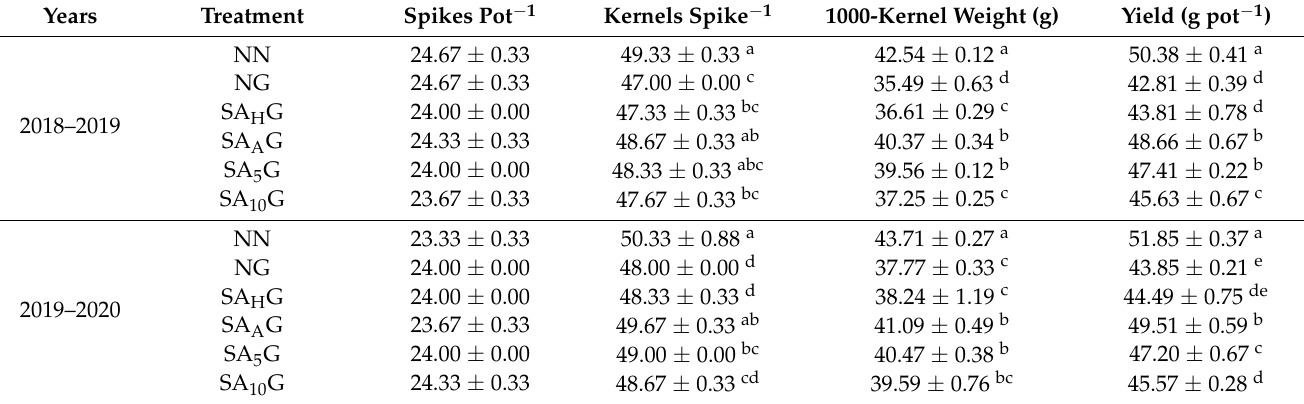
Table 2. Effects of exogenous salicylic acid (SA) spraying on wheat yield and yield components under high temperature stress during the grain-filling period in